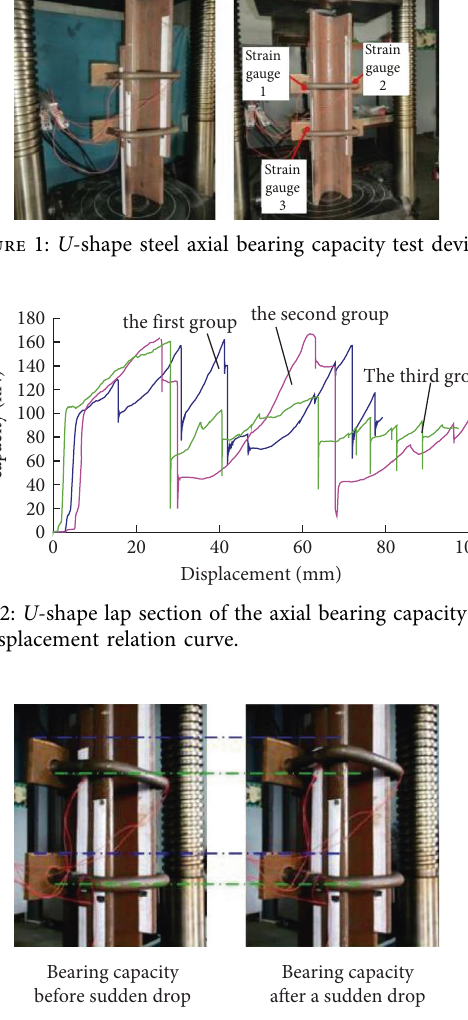
Figure 3: Te deformation of the truck before and after the bearing capacity drop.